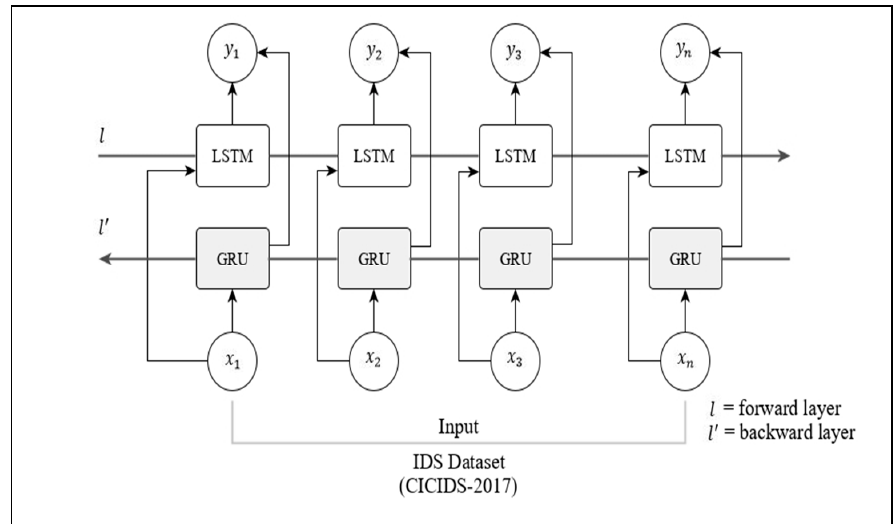
Figure 6. Bidirectional RNN architecture.